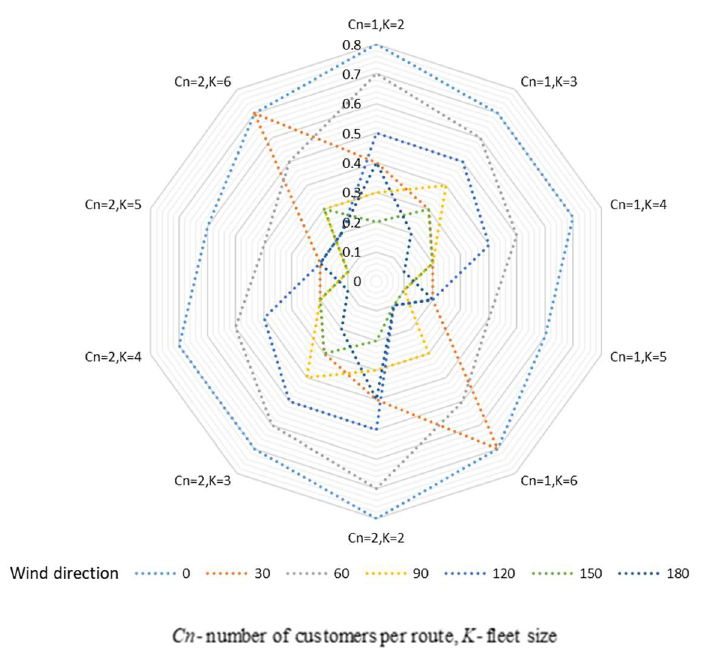
Figure 16. Customer satisfaction levels for the sub-missions created for different wind directions and with different combinations of fleet size and numbers of customers per route.